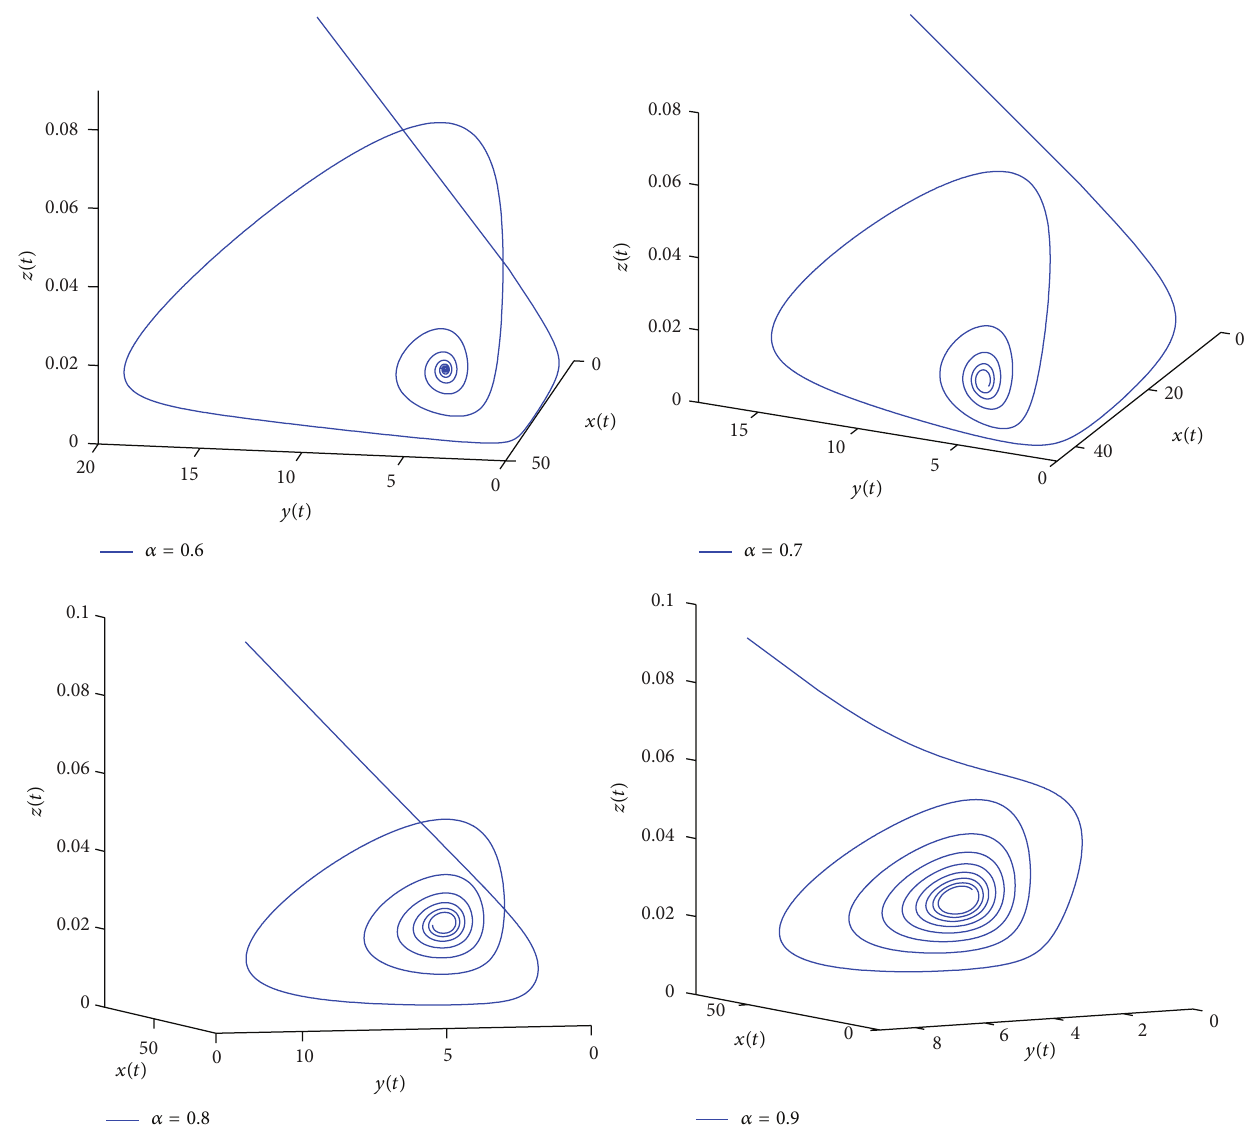
Figure 3: The three-dimensional diagrams show the approximate solutions of 𝑥(𝑡) , 𝑦(𝑡) , and 𝑧(𝑡) for 𝛼 = 0.6 , 𝛼 = 0.7 , 𝛼 = 0.8 , and 𝛼 = 0.9 in condition of 𝐷(𝑃) < 0